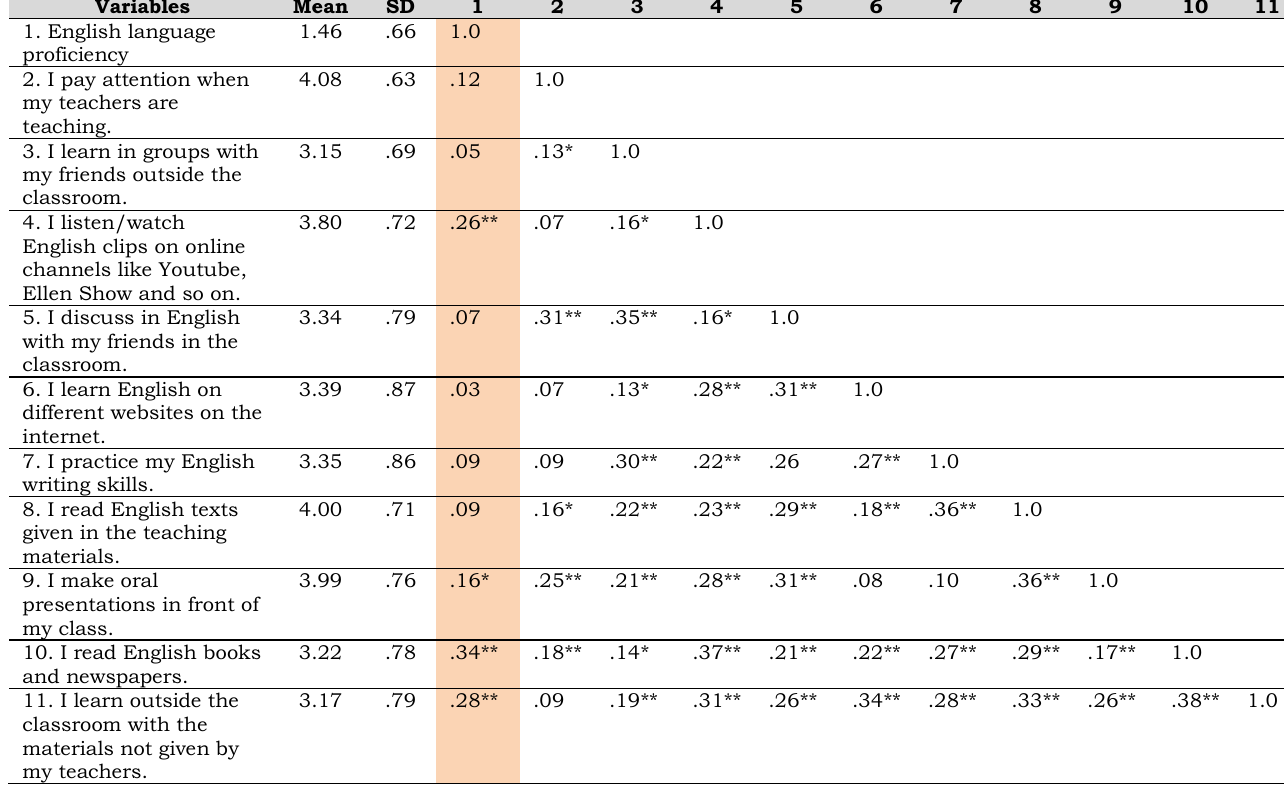
Table 2: Correlation Matrix (observed variables) of students’ EP and their involvement in term of efforts Variables